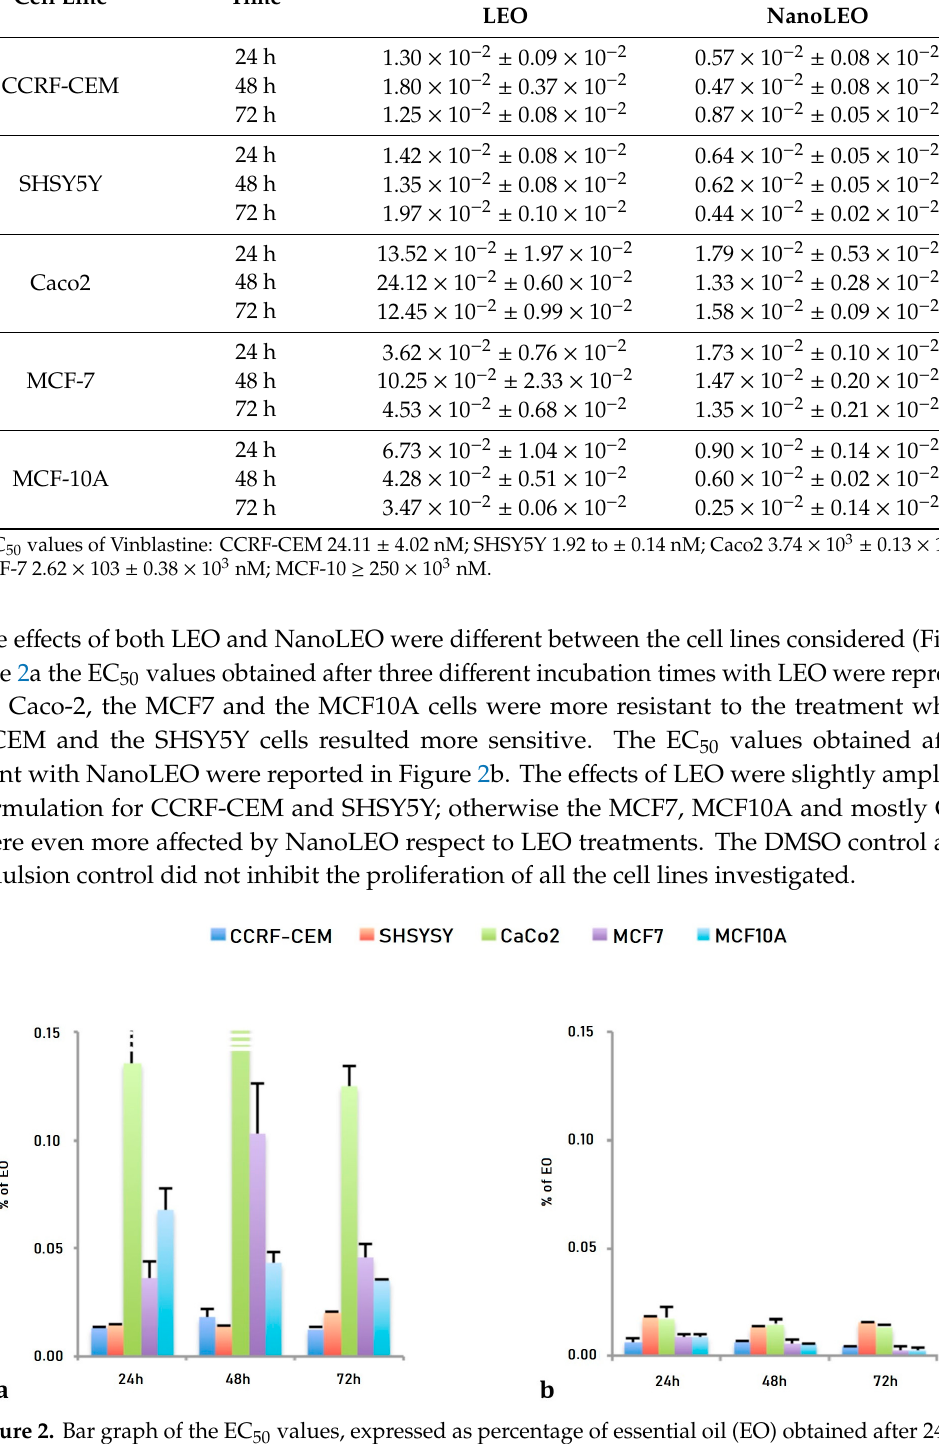
Table 2. LEO and NanoLEO EC 50 values obtained by dose-dependent MTT ((3-(4,5-Dimethylthiazol- 2-yl)-2,5-Diphenyltetrazolium Bromide) assay after 24, 48 and 72 h of treatments. The values are expressed as mean ± SD. Vinblastine was used as positive control 1 . p < 0.05 according to ANOVA test.